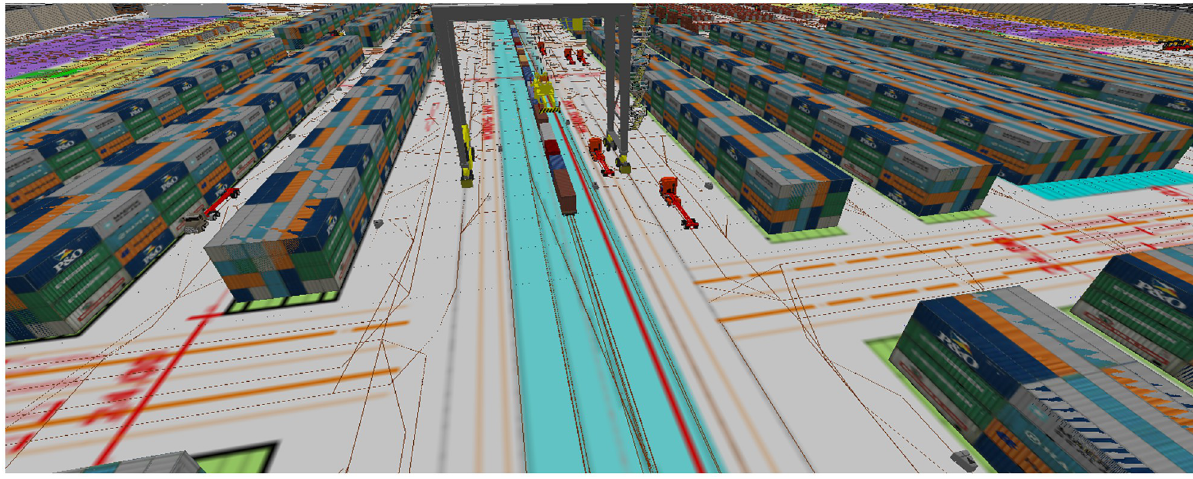
Fig 8. Rail area of a DES model representing the new LICD layout with an RTG.